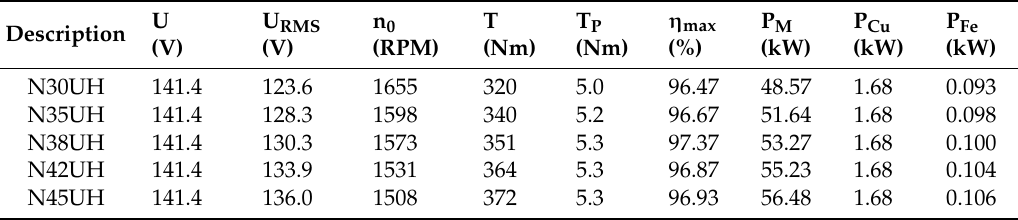
Table 10. Impact of the use of magnets made of various magnetic materials on the obtained ERPMSM